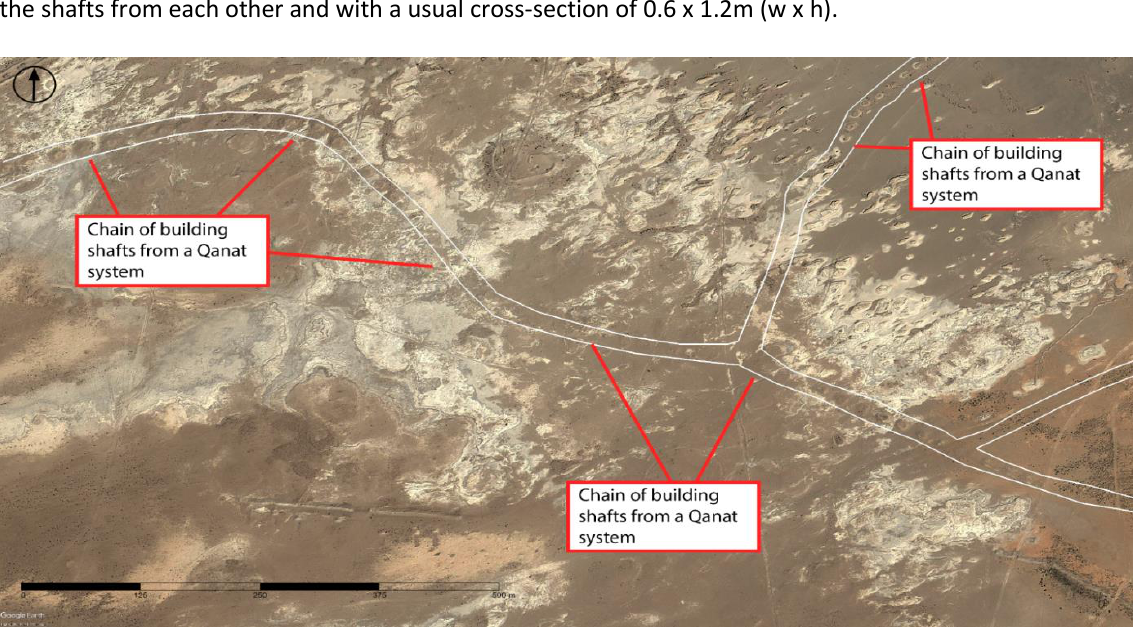
Figure 12: Arriving Qanat system west of Ar-Rafi'ah looking from the South. (Google / Maxar Technologies